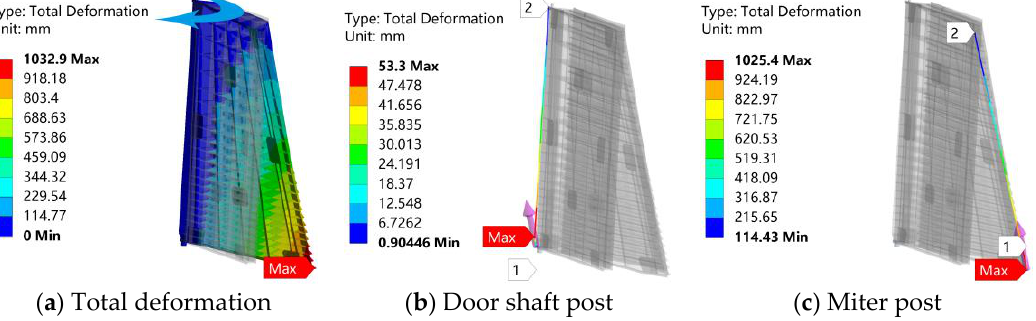
Figure 17. ( a ) Deformation of the overall structure of the backless tie rod gate, ( b ) Deformation of the door shaft column, and ( c ) Deformation of the miter column under the door-closing condition.